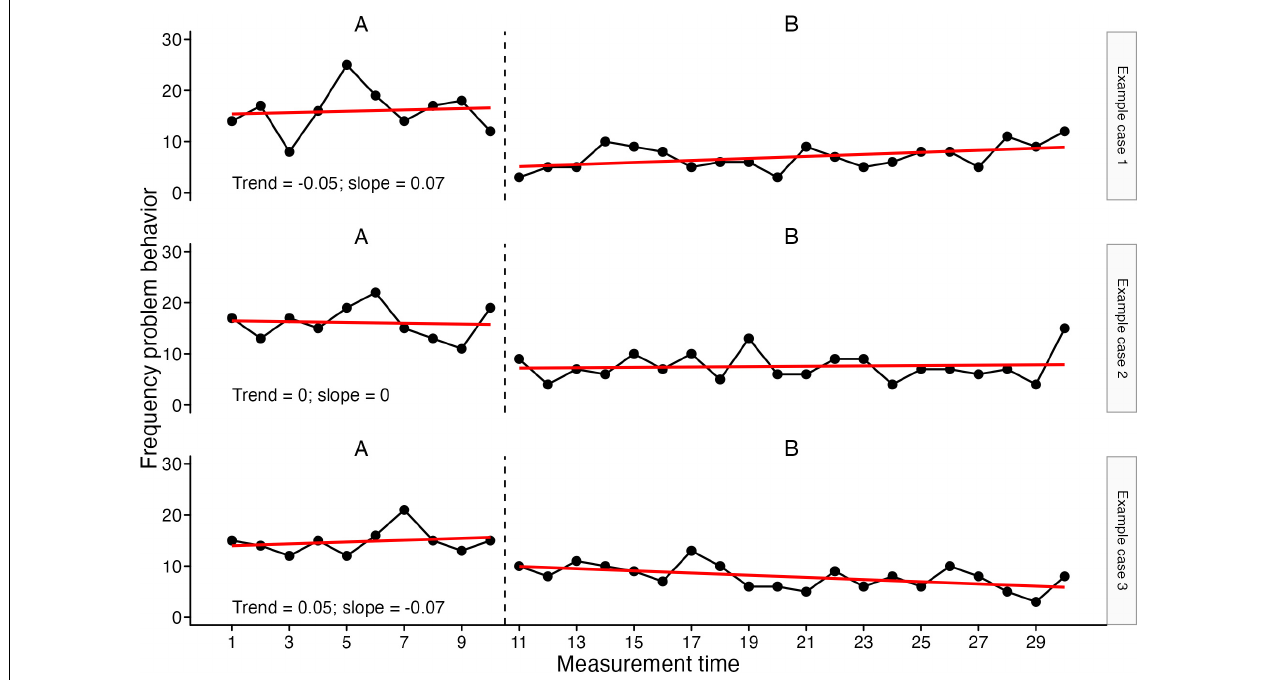
FIGURE 2 | Three random single cases based on exemplary design specifications.